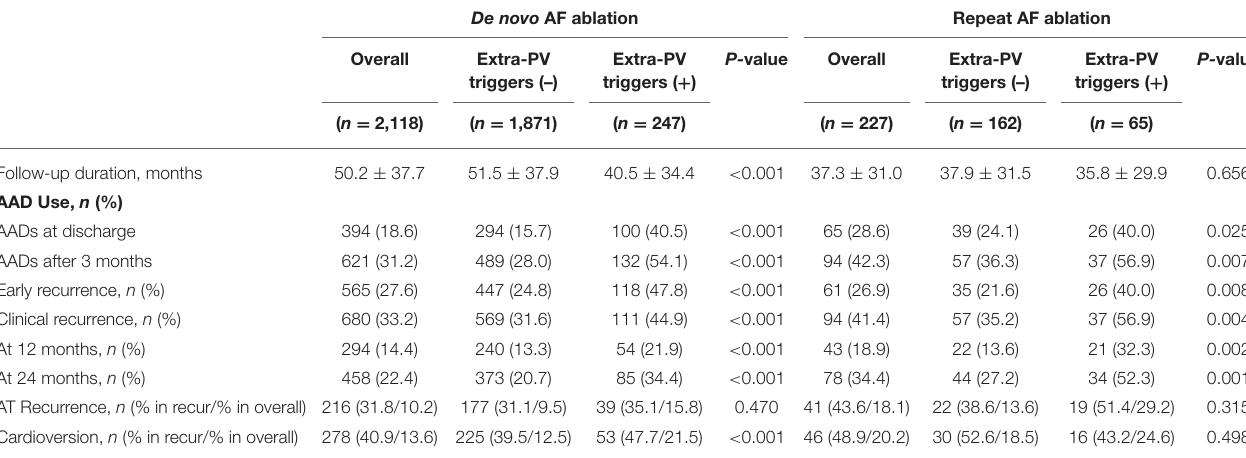
TABLE 4 | Clinical rhythm outcomes according to the existence of extra-PV triggers.